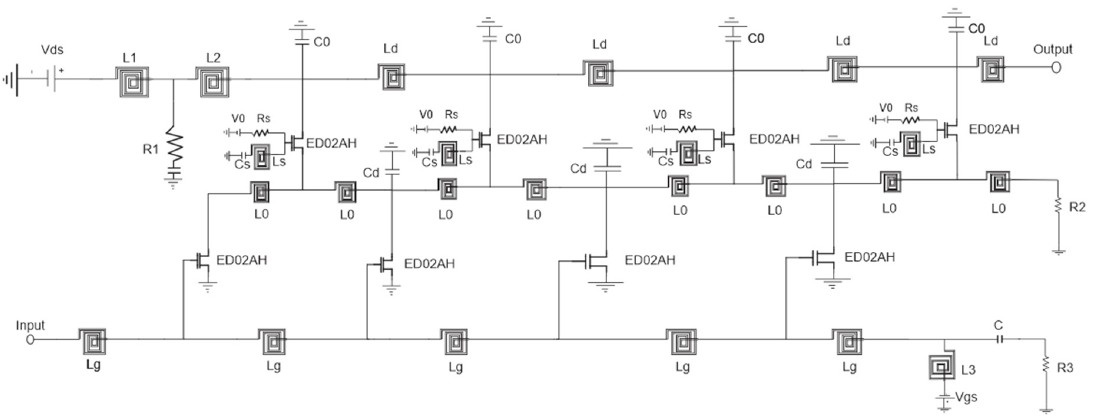
Figure 3. Schematic of the Low Noise Amplifier (LNA).